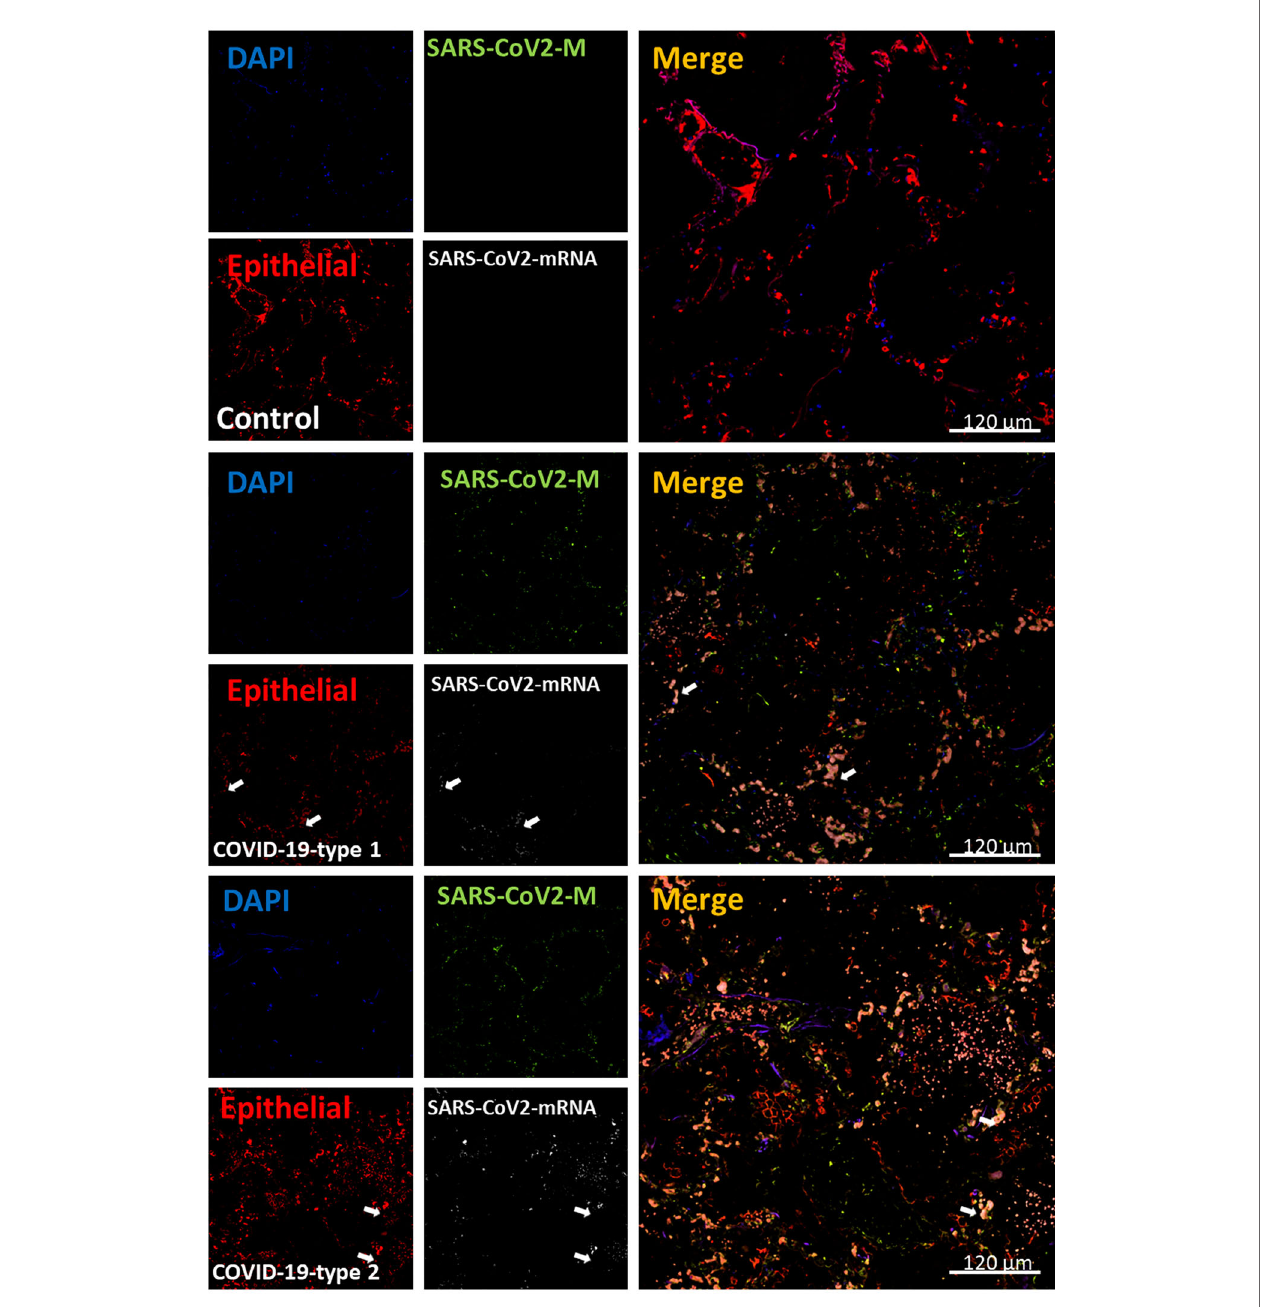
FIGURE 10 | COVID-19 disease induces widespread loss of epithelial cells and compromised polarity, all essential lung function components. Staining for nuclei (DAPI, blue staining), SARS-CoV-2 protein M (SARS-CoV-2-M, green staining), EpCAM (epithelial marker, red staining), and SARS-CoV-2-mRNA (White staining) were performed. 3D reconstructions of lung samples collected from uninfected (control) and COVID-19 (Type 1 or 2, enhanced coagulation and immune in fi ltration phenotype). In control conditions, EpCAM positive cells underline the alveolar wall as expected (Control). In contrast, in the enhanced coagulation phenotype (COVID- 19, type I, damage), a large amount of staining was widely distributed in the lung, but localization was random (COVID-19-type 1). Again, most viral protein M was concentrated inside blood vessels. Also, a population of EpCAM positive cells is positive for viral mRNA (see white arrows). In the immune in fi ltrating conditions, also we observed signi fi cant staining for EpCAM. However, the EpCAM staining was mostly dissociated from the alveolar wall, and groups of epithelial cells can be observed in the alveolar space, even losing their EpCAM polarity, suggesting that cells are probably lost. Thus, the epithelial layer in COVID-19 cases is not functional (n = 13-15 different cases analyzed with a least fi ve sections